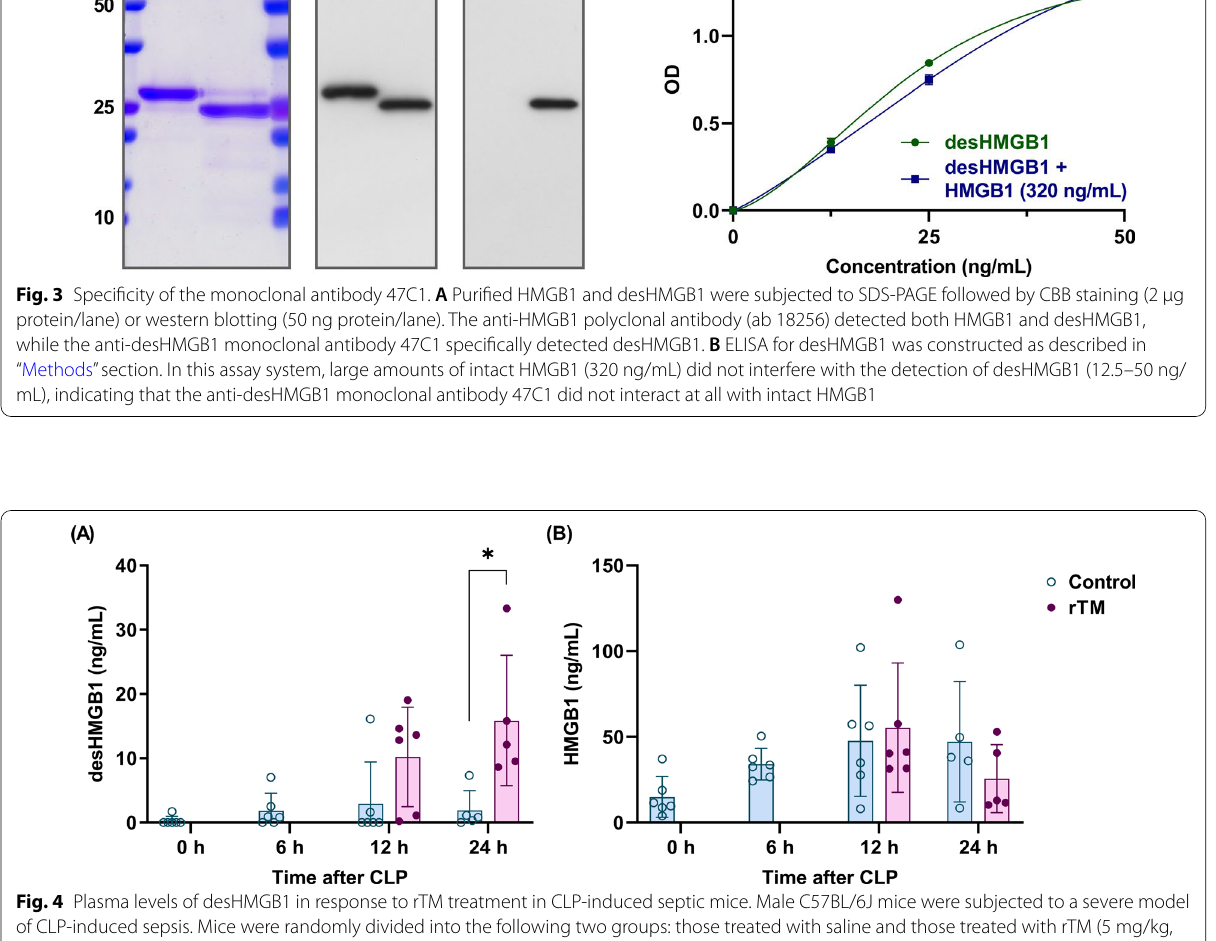
standard deviations. Statistical ±